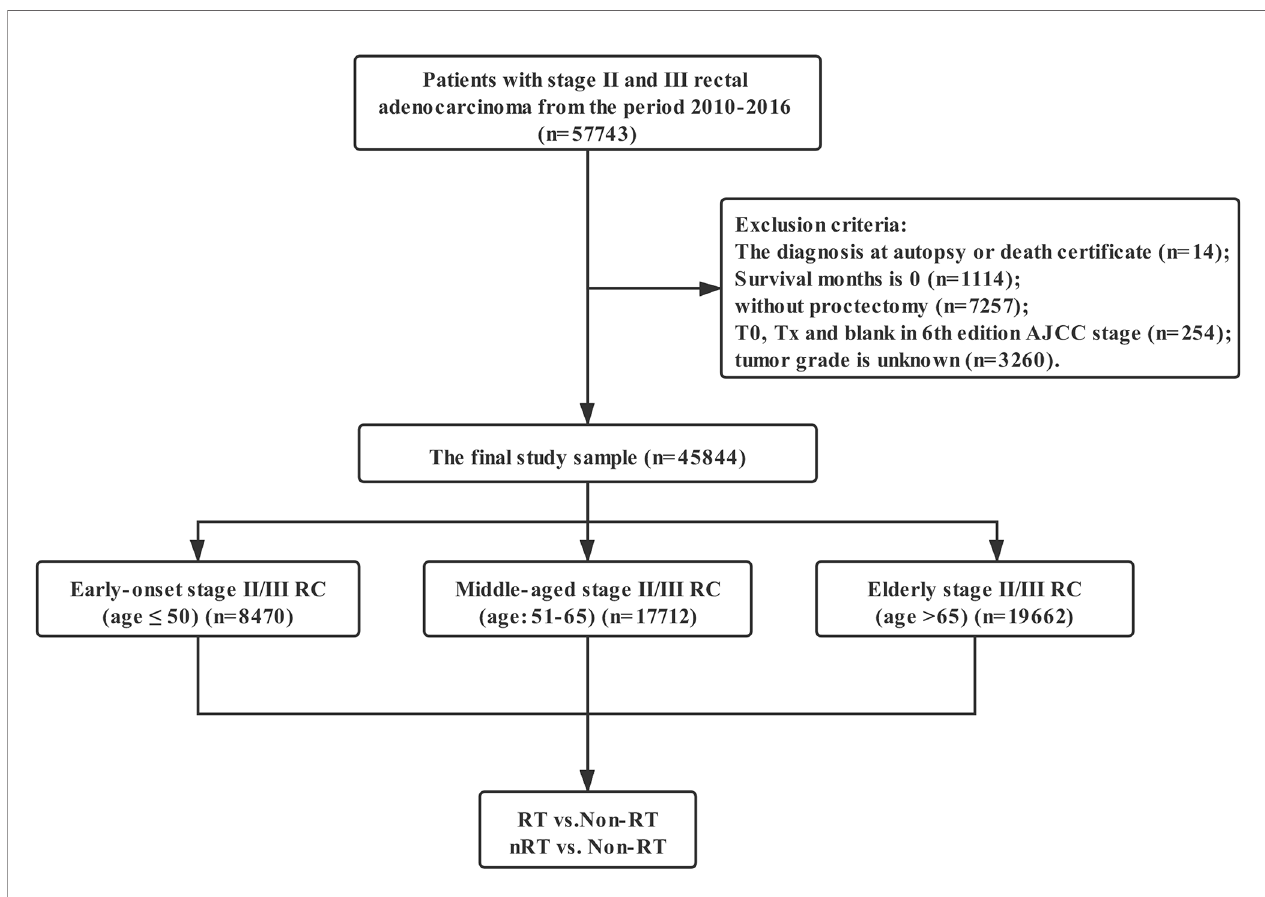
FIGURE 1 | The fl ow